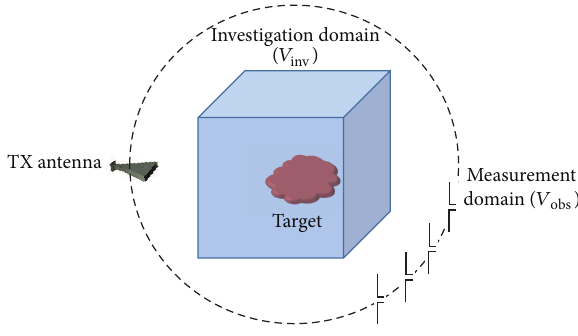
Figure 1: Imaging